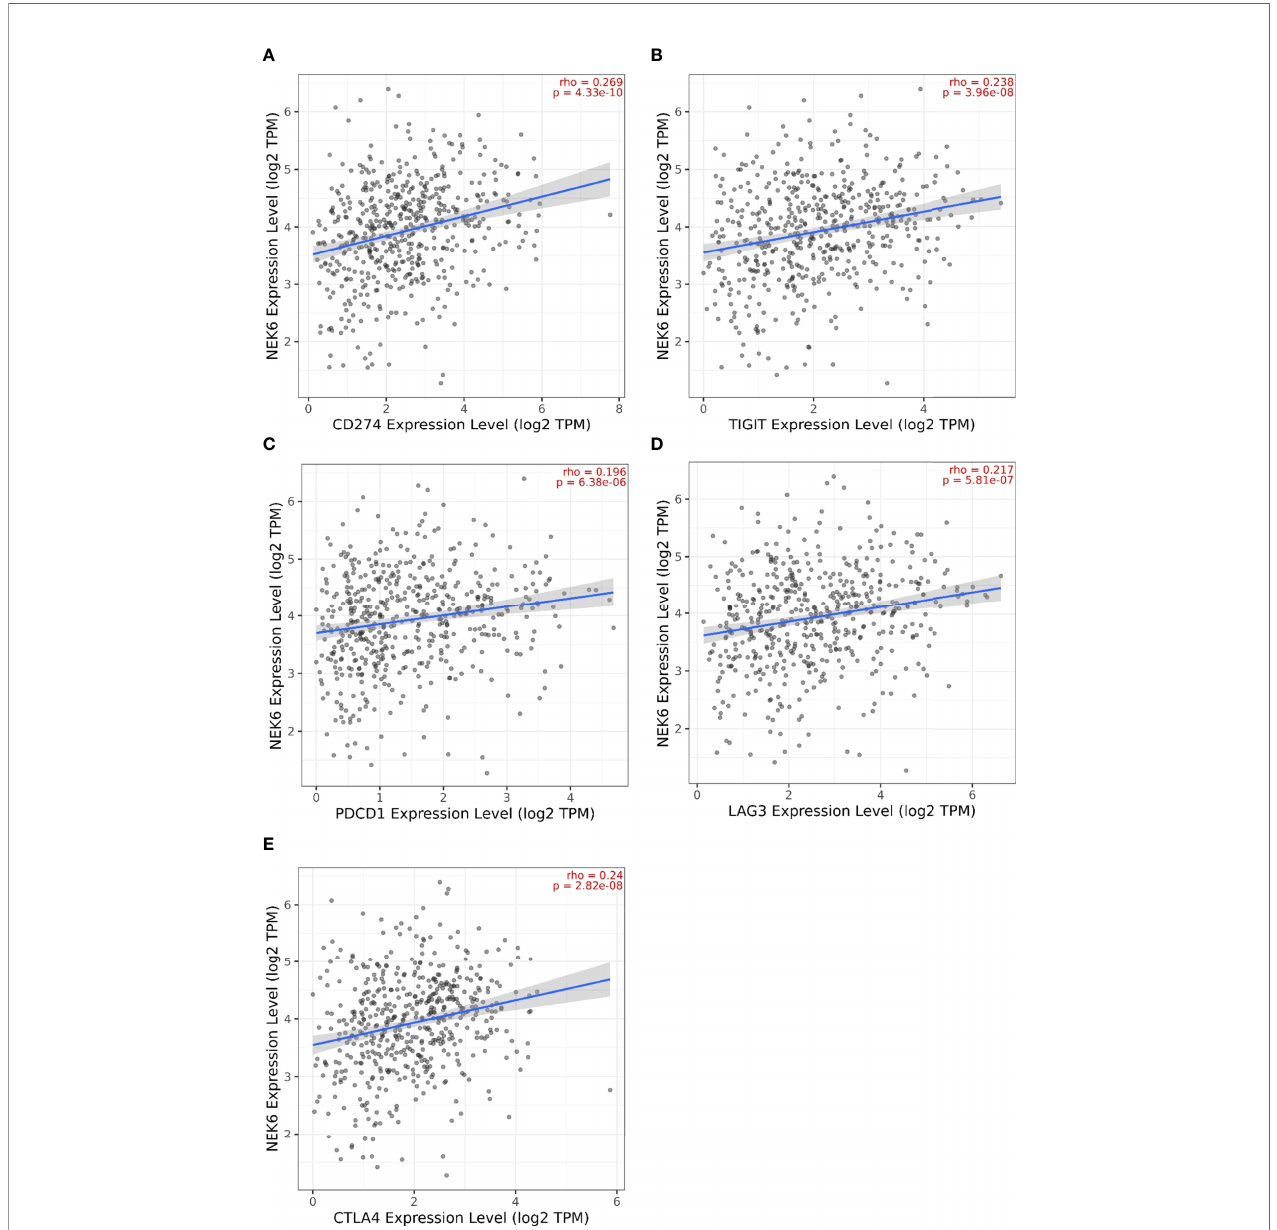
FIGURE 6 | Immune checkpoint marker associated with NEK expression in HNSCC. Scatterplots of the correlations between NEK6 expression and CD274 (A) , TIGIT (B) , PDCD1 (C) , LAG3 (D) and CTLA-4 (E) in HNSCC using the TIMER